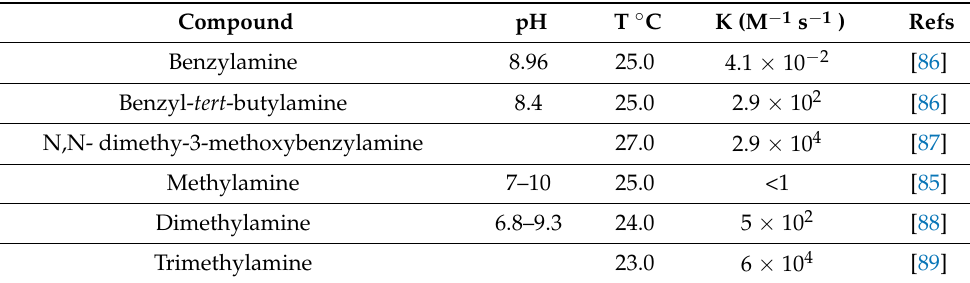
Table 2. Second-order rate constants for reactions of chlorine dioxide with aliphatic amines.